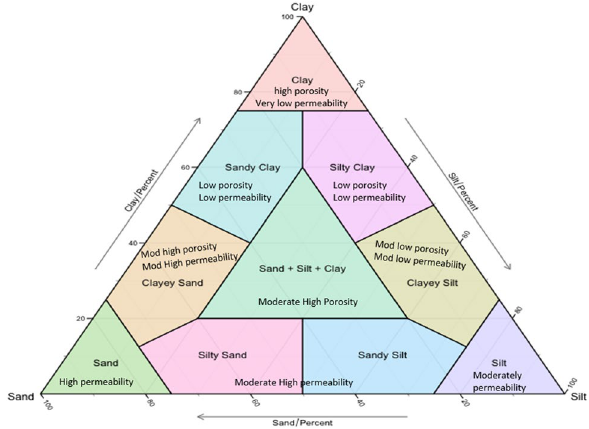
2 pore size distribution